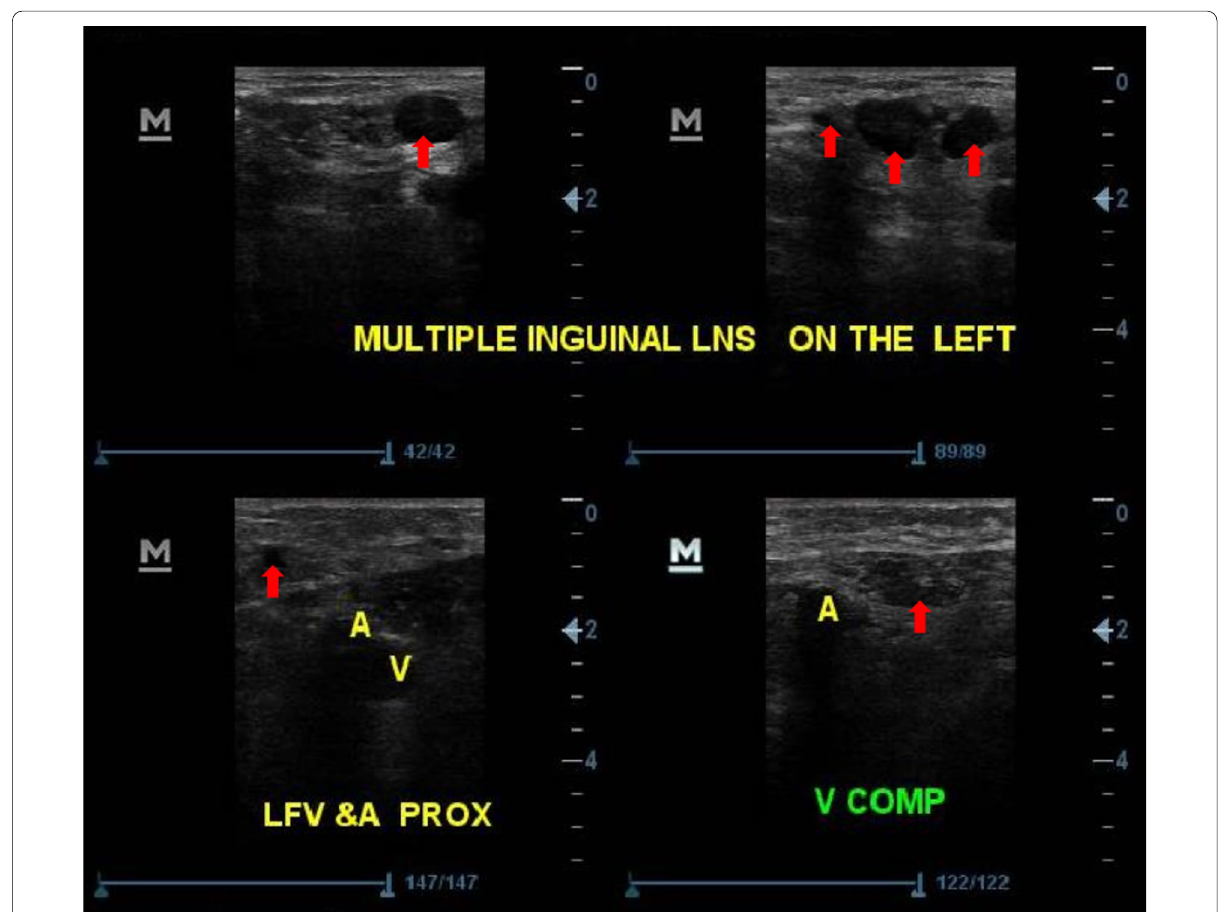
Fig. 4 Sonograms of a left lower limb performed for a 65‑year‑old female who reported with a two‑day history of swelling of the left lower limb. It shows multiple hypoechoic rounded inguinal lymphadenopathies as shown by the red arrows. Also noted is a normal left deep femoral vein with complete